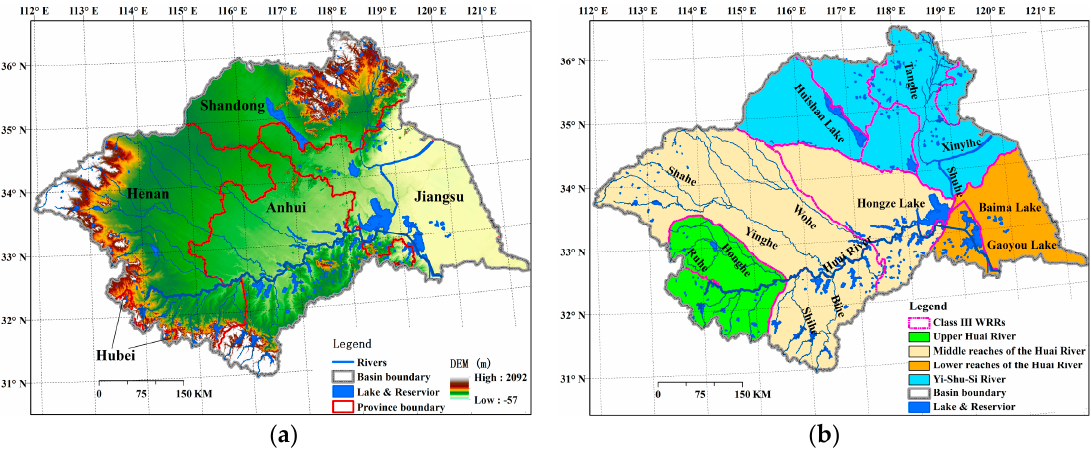
Figure 1. Political boundary and digital elevation of the Huai River Basin. ( a ) Boundaries of second-class water resource regions (Class II WRRs) and ( b ) third-class water resource regions (Class III WRRs), main rivers, and tributaries.